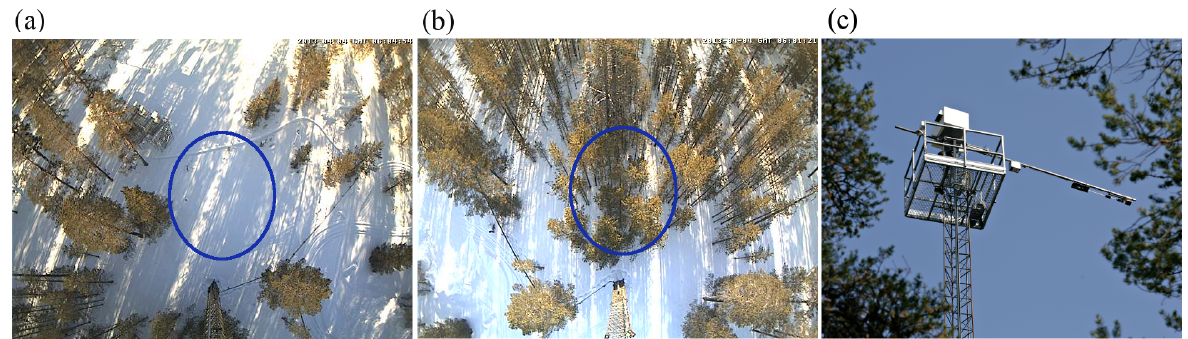
Figure 9. Mast-spectroradiometer measurement areas of (a) a forest opening and (b) a sparse pine forest as well as (c) a photograph of the mast top